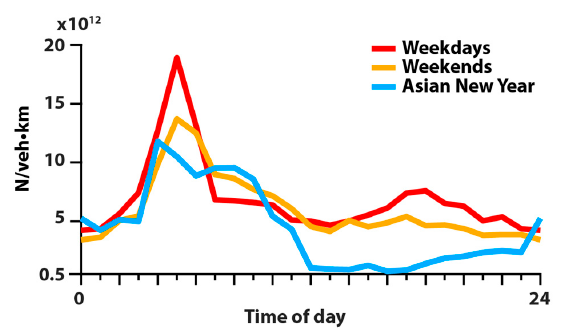
Figure 9. Diurnal patterns of vehicle emission rate for weekdays, weekends, and in period of Asian New Year.